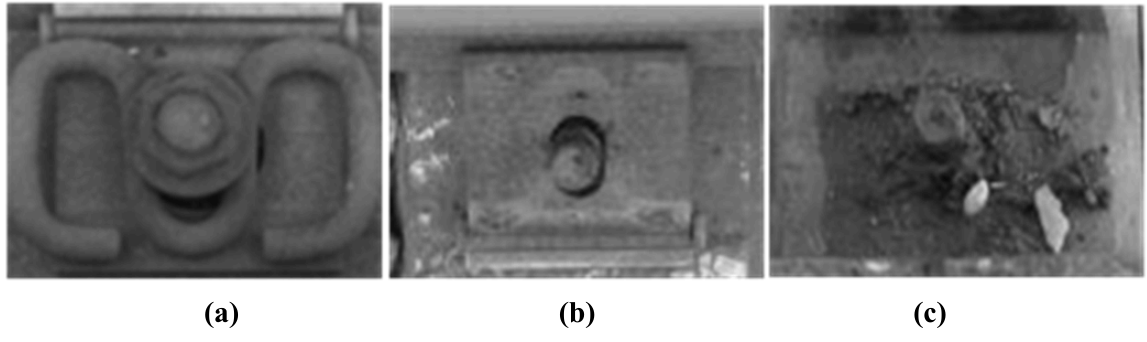
Figure 9. ( a ) Fastener image; ( b and c ) Fastener